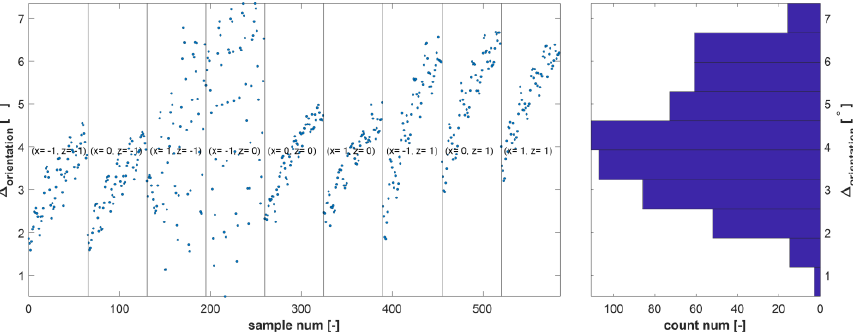
Figure 12. The trueness of the tracker orientation measurements ( left ) and their histograms ( right ). The average measurement deviation of the tested tracker orientation was about 4°.